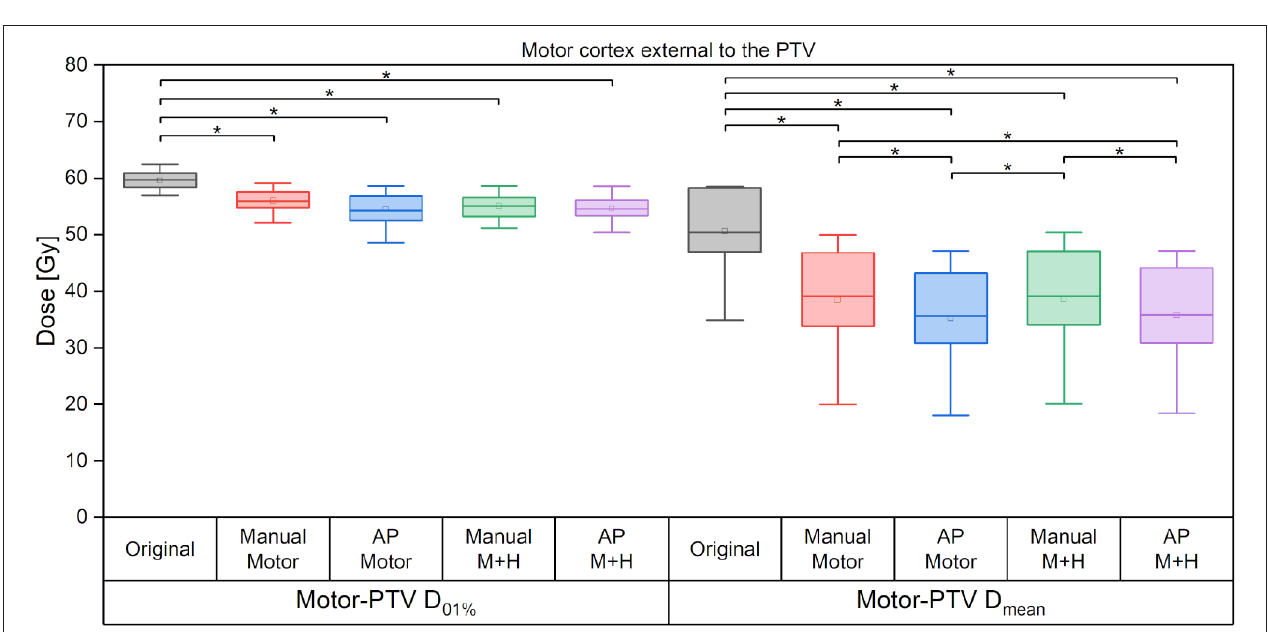
FIGURE 8 | Maximum and mean dose to the motor cortex. Line = median value, square = mean value, diamond = outliers, star = statistically significant at p < 0.005.